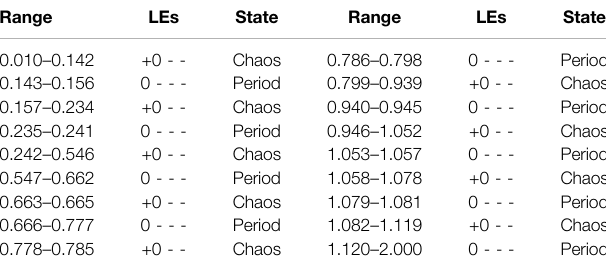
TABLE 2 | The state and LEs under the change of parameter b .